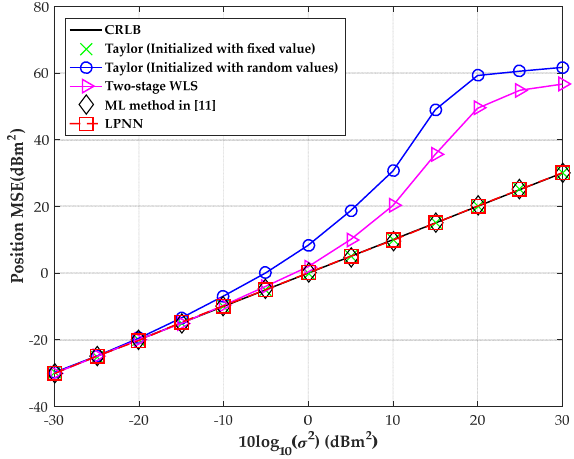
Figure 9. MSE versus level of measurement noise with randomly selected source positions.